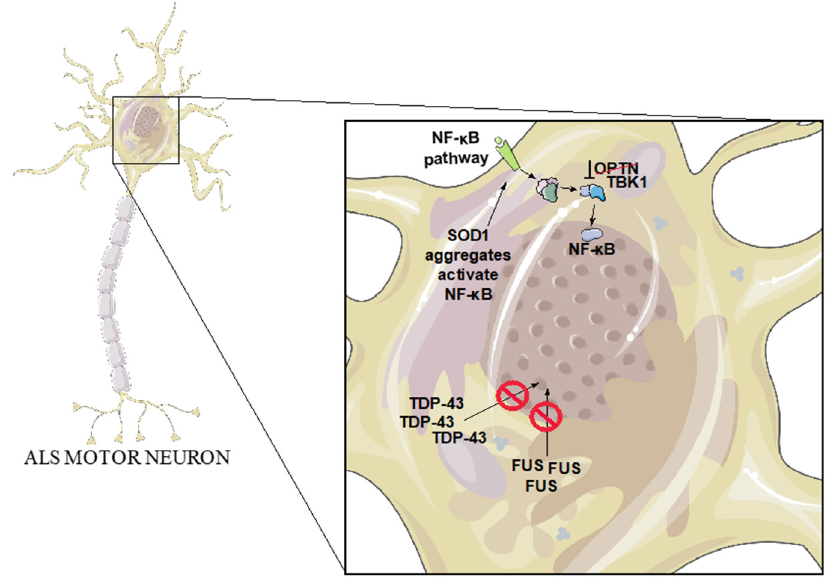
Figure 2. Schematic representation of a motor neuron showing how major genetic risk factors linked to amyotrophic lateral sclerosis (ALS) may affect the NF- κ B pathway. The NF- κ B pathway can be activated by either SOD1 protein aggregation or other stimuli. OPTN has limited ability to inhibit the NF- κ B pathway when carrying loss-of-function ALS mutations. Mutated TBK1 is unable to bind to OPTN but may still be regulating the NF- κ B pathway. Both TDP-43 and FUS, which usually bind to NF- κ B in the nucleus, accumulate in the cytoplasm and may fail to maintain their nuclear activity in conditions leading to ALS.